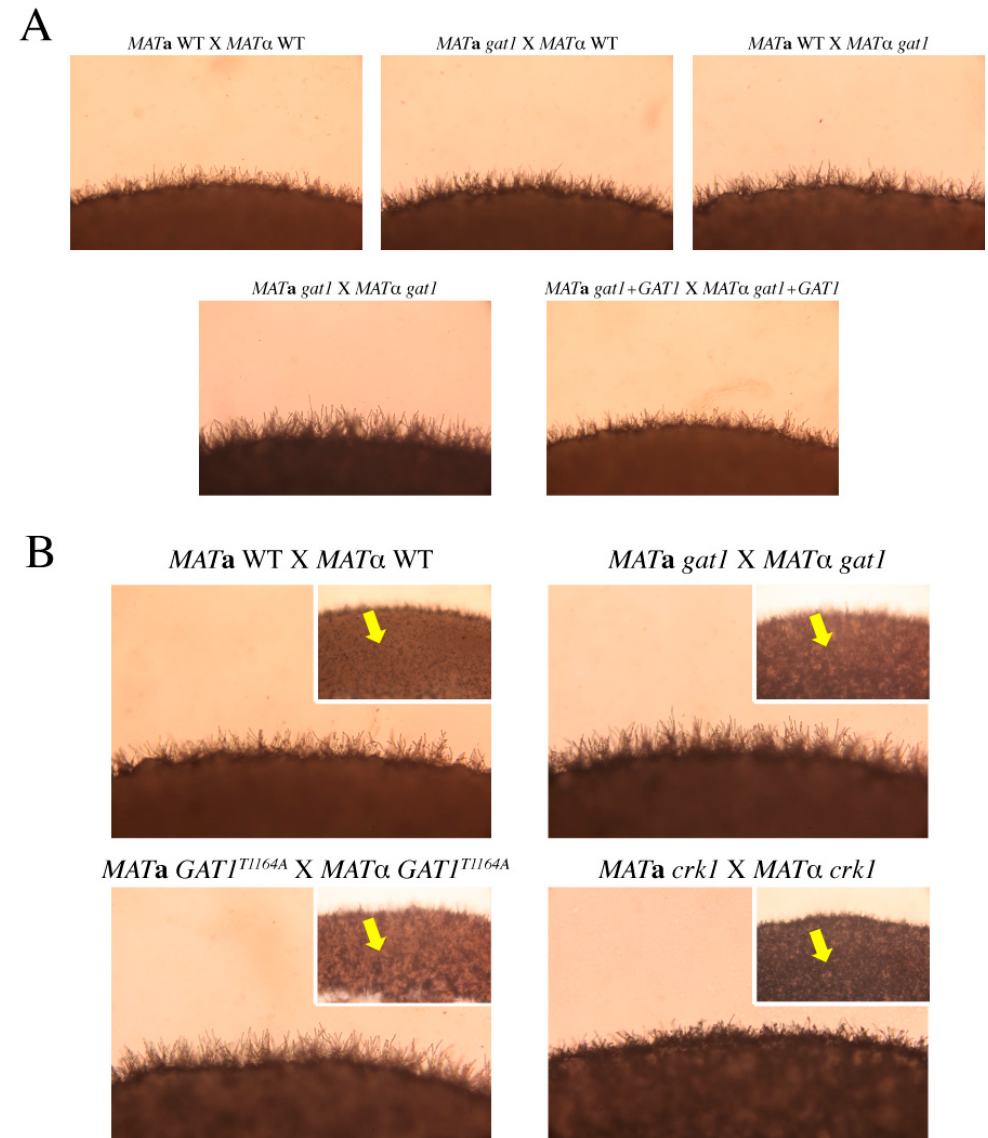
Figure 6. Dikaryotic filamentation and aerial hyphae formation were enhanced in the bilateral gat1 mutant and GAT1 T1164A mutant crosses. ( A ) C. neoformans MAT a and MAT α gat1 mutant and overexpression strains were crossed as indicated and compared to the wild type cross. ( B ) C. neoformans MAT a and MAT α GAT1 T1164A bilateral mutant cross was performed and compared to the crosses as indicated. Small photos reveal the density of aerial hyphae. Yellow arrow indicates aerial hyphae. Mating was conducted on V8 agar plates and incubated at 26 ° C in the dark. Photos were taken 24 h post-incubation at 100× magnification.